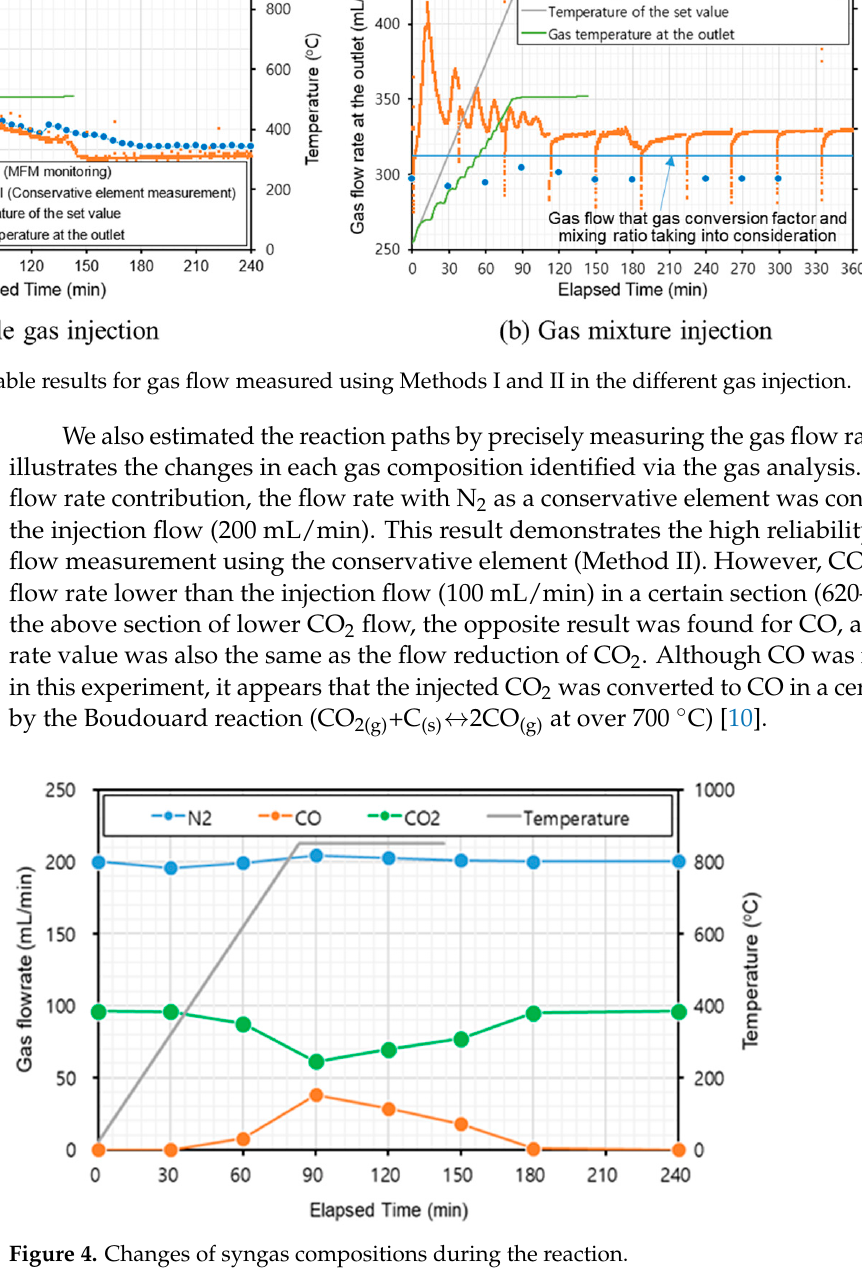
Figure 4. Changes of syngas compositions during the reaction.